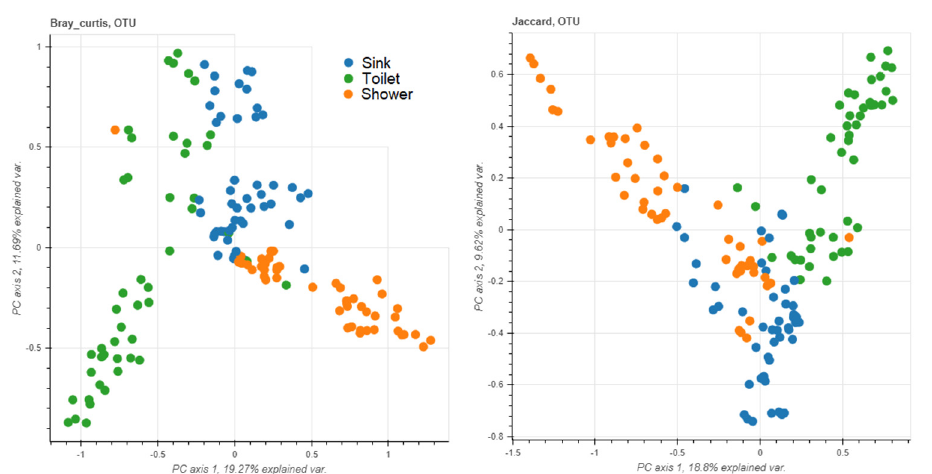
Figure 3. Principal coordinate analysis (PCoA) plot with Bray–Curtis ( left ) and Jaccard ( right ) dissimilarity highlighting operational taxonomic unit (OUT) differences and similarities between MH samples linked to the sampling site.